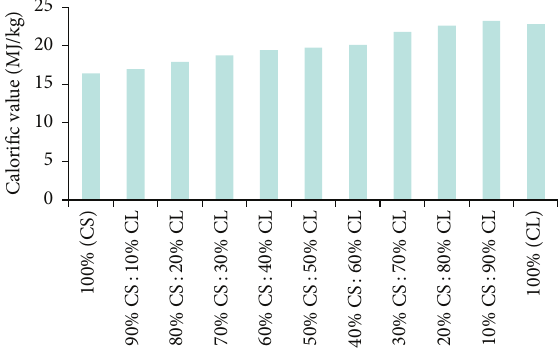
Figure4:Energycontentofpureandblendedsamplesofcornstover and